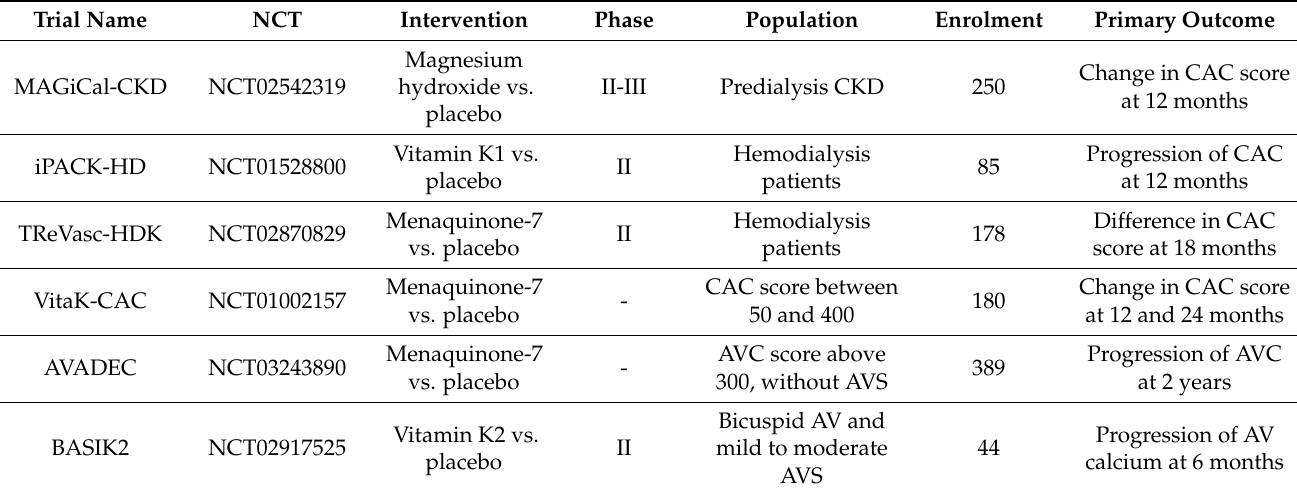
Table 2. Ongoing clinical trials evaluating the effects of nutraceuticals on vascular